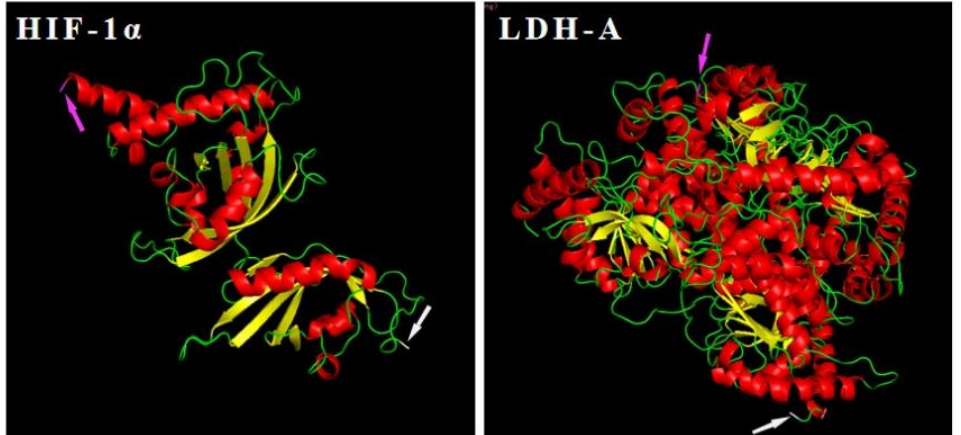
Figure 5. The three-dimensional structures of HIF-1 α and LDH-A protein. Magenta arrows point to the N-term and gray arrows to the C-term. The α helices, β sheets, and loop are colored in red, yellow, and green, respectively.